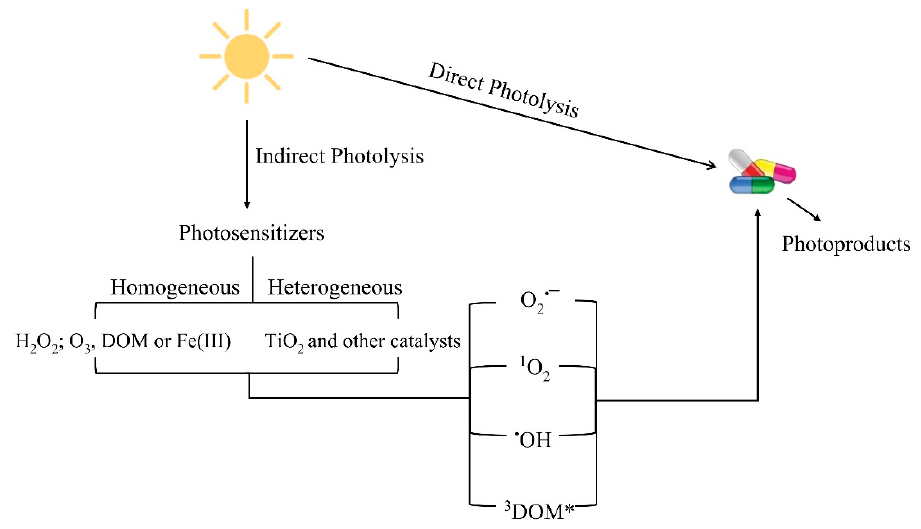
Figure 1. Representation of photolysis pathways of organic compounds in aquatic matrices.